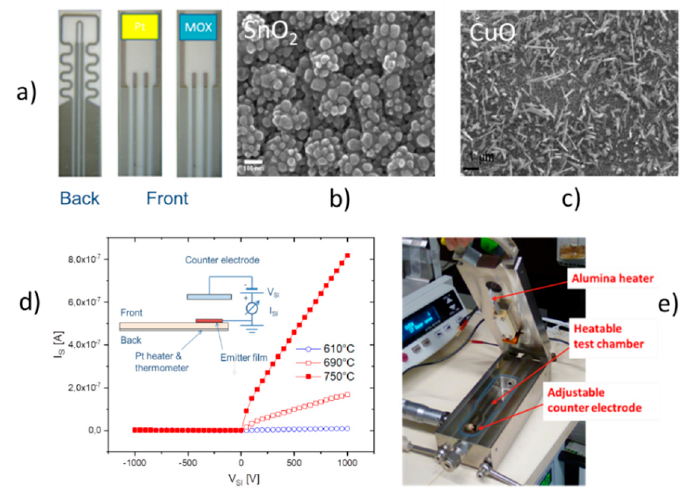
Figure 4. ( a ) Ceramic chips with back-surface Pt heaters and front-surface electrodes for contacting emitter layers; ( b , c ) MOX emitter materials deposited on the front-side using evaporation and thermal oxidation techniques [21–25]; ( d ) schematics of a vertical surface ionization read-out structure realized in a stainless-steel test chamber and resulting current-voltage characteristics observed upon ethene exposure (10 3 ppm in synthetic air); ( e ) stainless steel measurement chamber featuring a heatable emitter chip (top lid) and adjustable counter electrode (lower left).